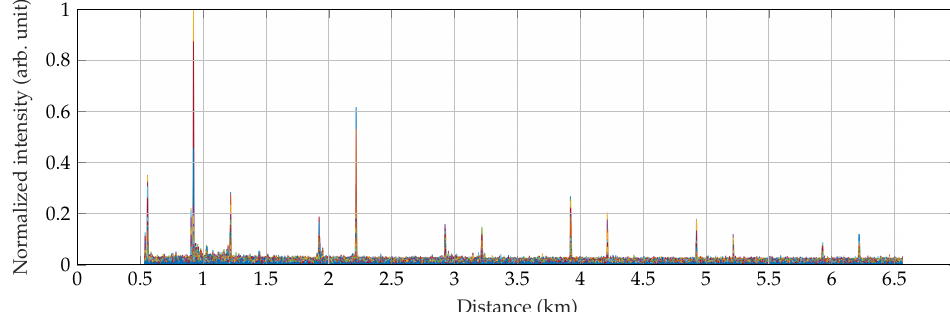
Figure 6. Detection of the walking can be recognized 12-times on the full length of 6 km.